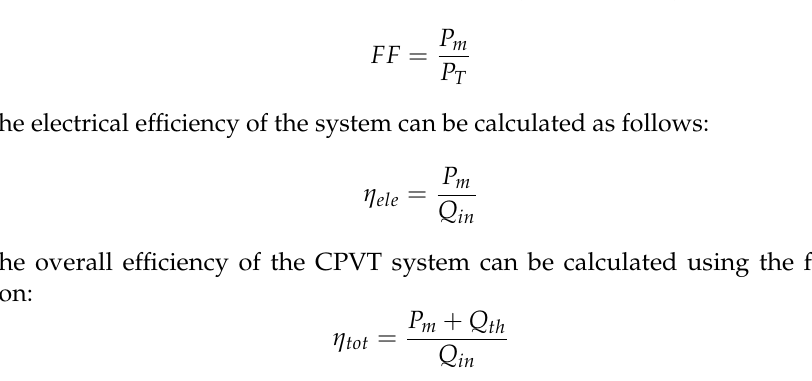
where Q cond is the conduction heat transfer rate, A is the layer area, k is the thermal conductivity of the material of the layer, and ∇ T is the temperature gradient. The solar energy converted to heat will be collected from the CPVT assembly by HTF or dissipated to the environment by convection and